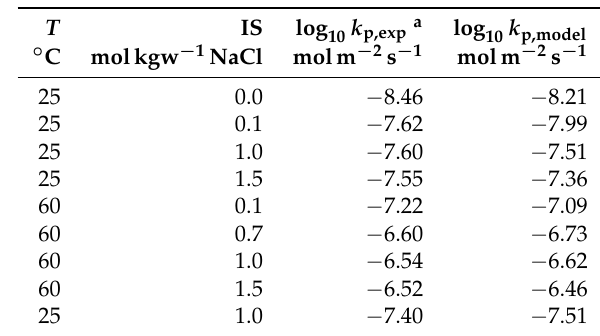
k p,exp a log k p,model 10 10